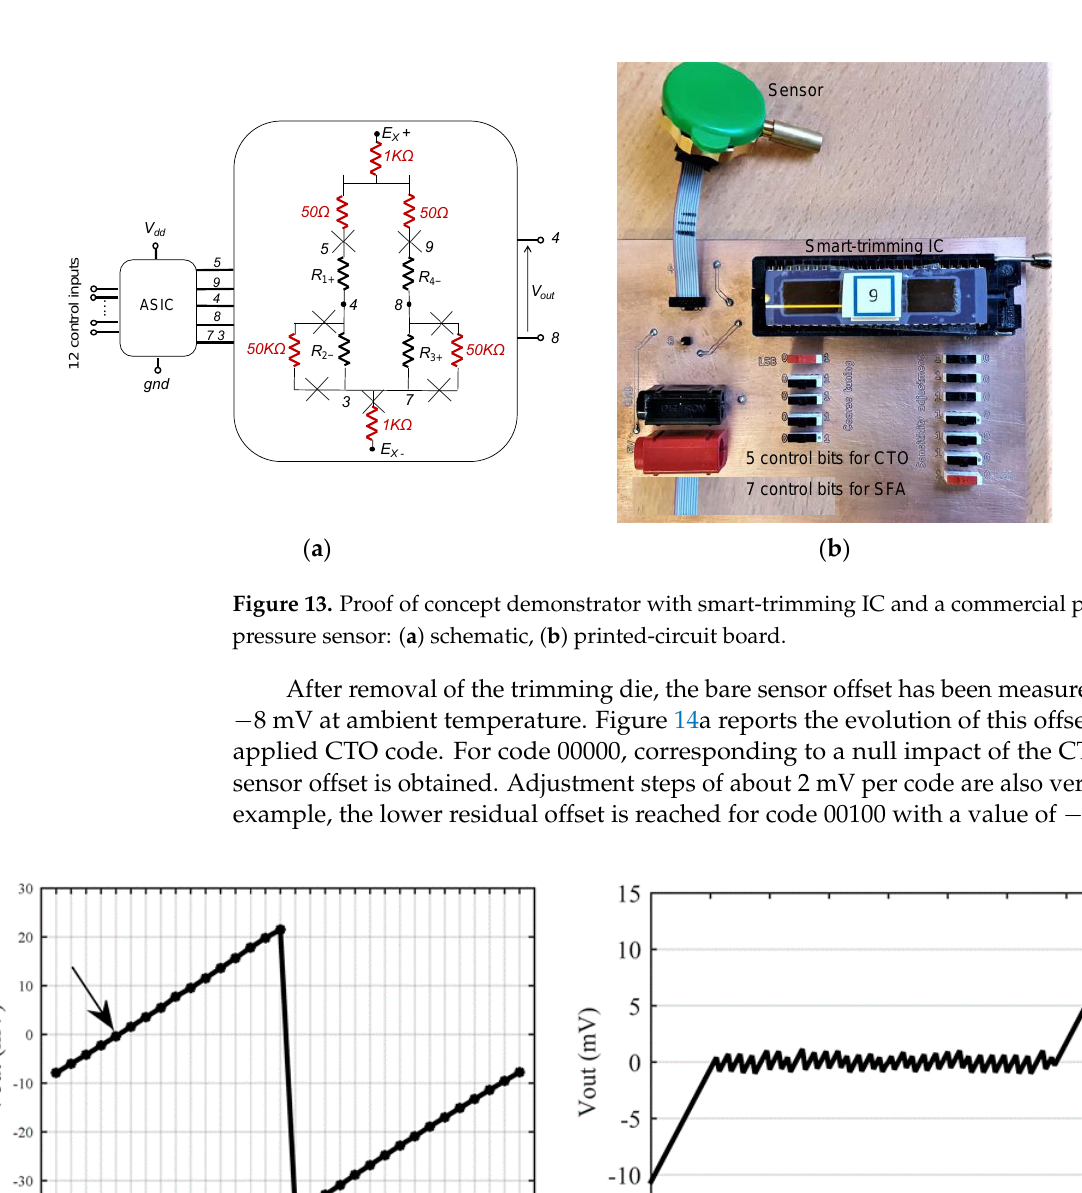
Figure 13. Proof of concept demonstrator with smart-trimming IC and a commercial piezo-resistive pressure sensor: ( a ) schematic, ( b ) printed-circuit board.